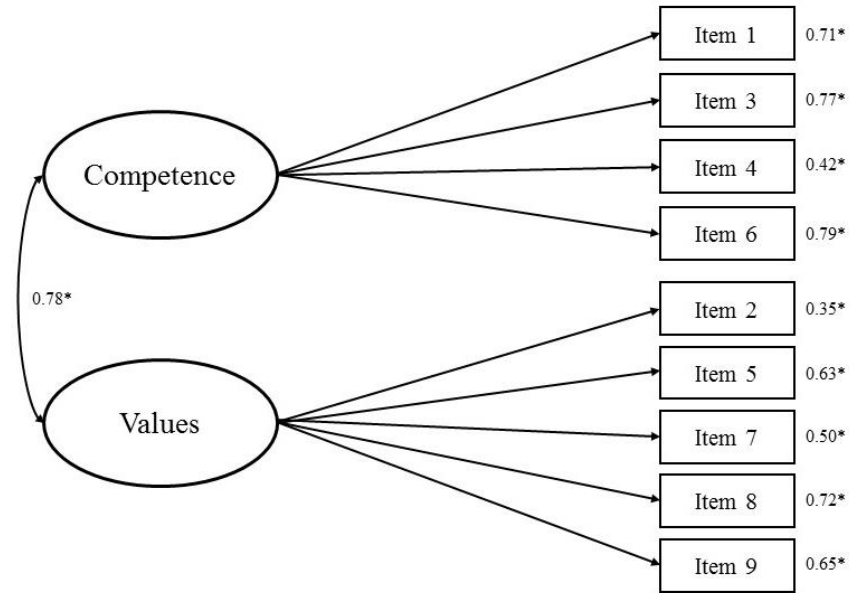
Figure 1. Confirmatory factor analysis results showing standardized estimates with errors for the Korean version of Health Care System Distrust Scale based on the two-factor model proposed by Shea et al. [22]. * p < 0.001.